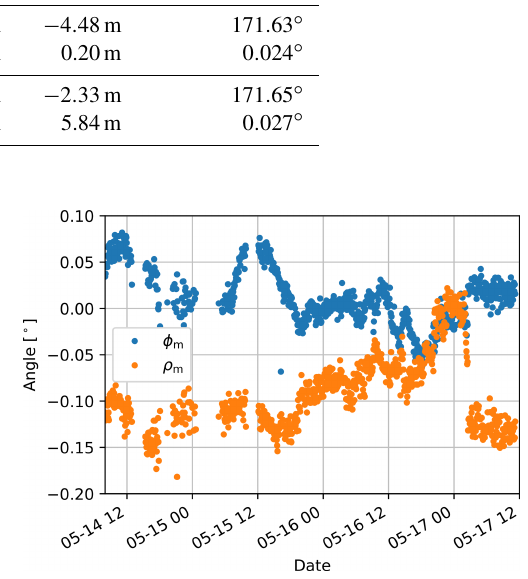
Figure 12. Roll ρ m and pitch φ m angles of the lidar measured by the SSL for a contiguous subset of the SSL scan